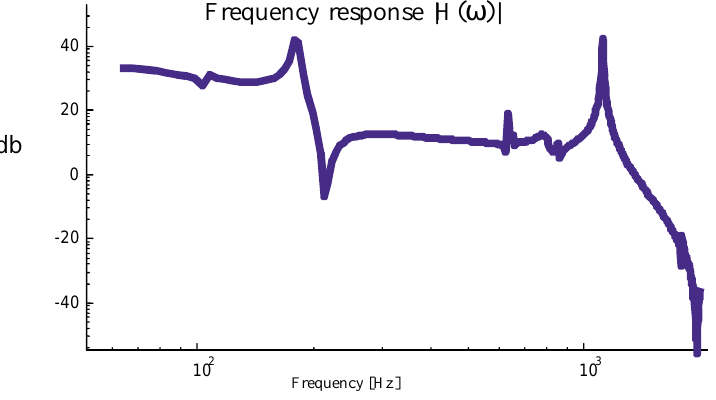
Fig. 3. Experimental set-up showing the excitation and measurement devices.